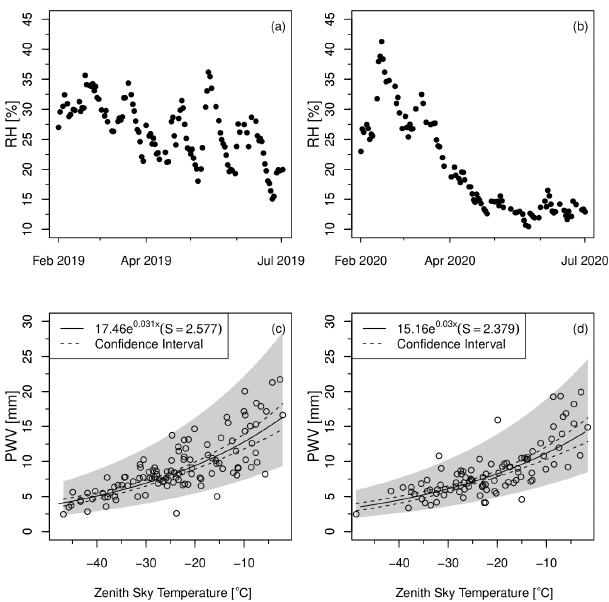
Figure A1. Panels (a) and (b) show time series of surface relative humidity measured at Socorro, New Mexico. (a) The period from February to July 2019 and (b) the values for February–July 2020. Panels (c) and (d) show the corresponding PWV and zenith sky temperatures for the same periods in 2019 (c) and 2020 (d)